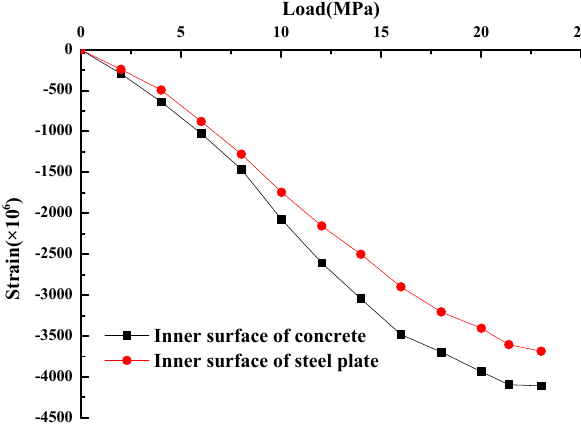
Figure 7. Load–hoop strain curves of model ZJ6. Figure 8. Load–hoop strain curves of model ZJ8. Figure 8. Load–hoop strain curves of model